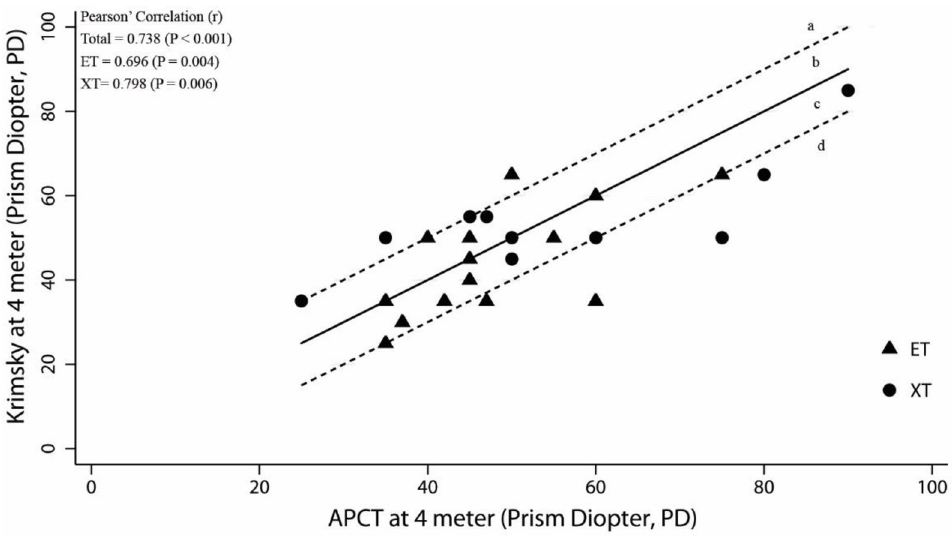
Fig 6. The relationship between angle of deviation from the Krimsky test with APCT at D. The solid line is the line of equality and the zone between dotted lines represents range ± 10 PD of the APCT values. The acceptable area were b and c. The unacceptable area were a and d. (ET = esotropia; XT =